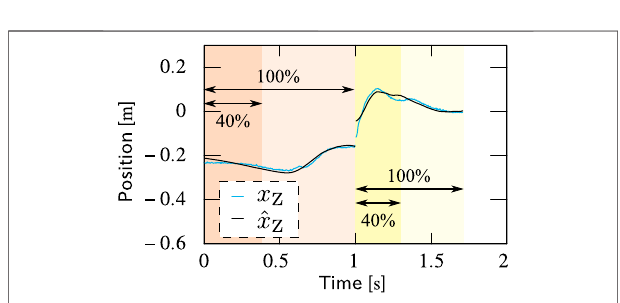
FIGURE 17 | Comparison between measured and reproduced trajectories of the ZMP. The latter was reproduced only from fi rst 40% of the observed motion data in each phase but fi ts the former.